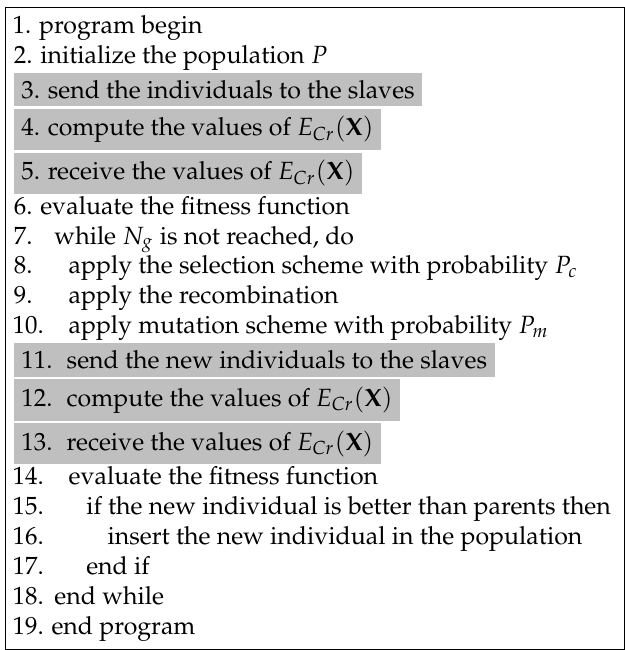
Figure 1. Pseudocode of the Genetic Algorithm (gray background indicates that the steps are